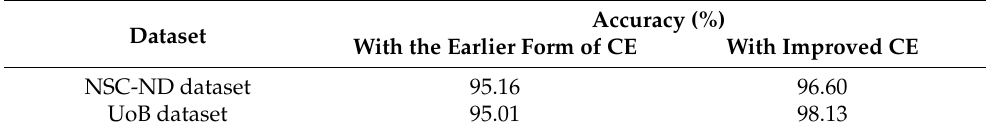
Table 3. Performance obtained on the EEG